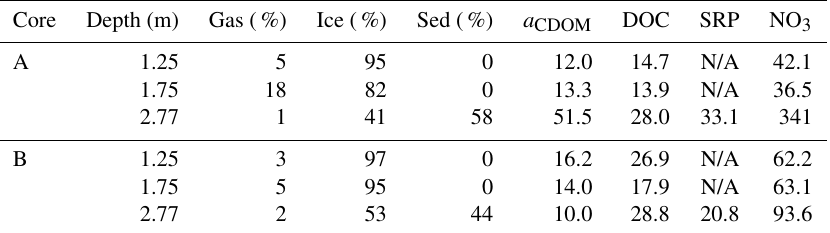
Table 2. Analysis from duplicate permafrost cores taken from palsas at the SAS2 study site. Gas, ice, and sediment (Sed) proportions (%) are by volume. a CDOM (m − 1 ) is the CDOM absorption at 440nm. Dissolved organic carbon (DOC, inmgL − 1 ) , soluble reactive phosphorus (SRP, in µgL − 1 ) , and nitrate-nitrogen (NO 3 , in µg NL − 1 ) concentrations are potential contributions from melted core ice. N/A = sample was below detection limit.